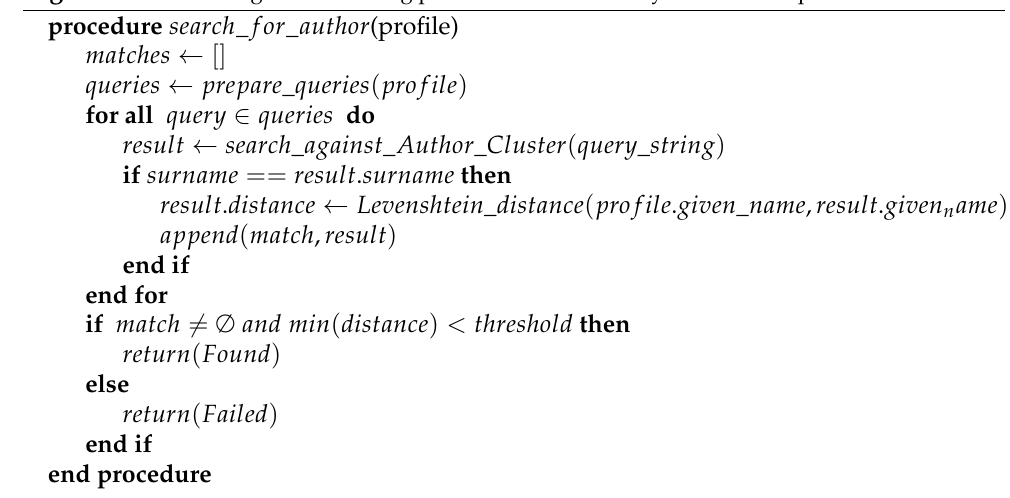
Algorithm 1 Searching for a matching profile between Ministry’s list and Scopus Authors’ cluster.